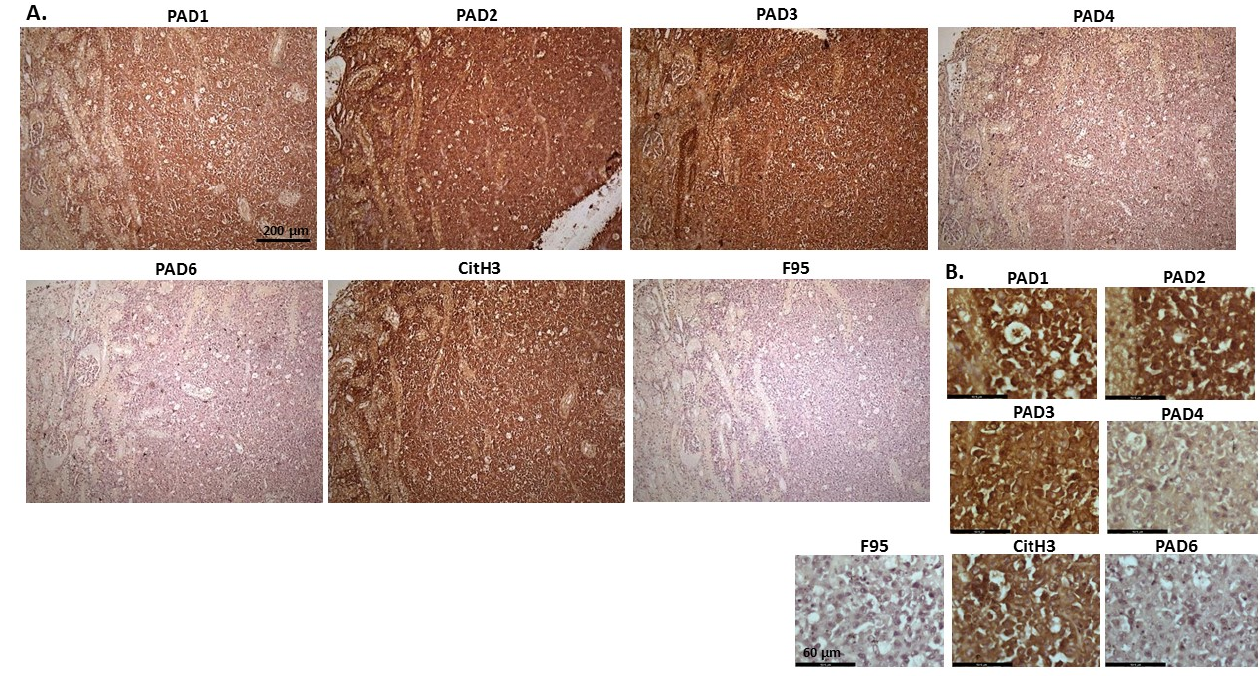
Figure 16. Cat, malignant tumour in kidneys; probably lymphoma. ( A ) Overview images for PAD1, 2, 3, 4, 6, CitH3, and F95 stainings of serial tissue sections; scale bar represents 200 μ m for all images; 10× objective. (B) Higher magnification shown for each staining from the images in ( A ); scale bar represents 60 μ m for all images; 40× objective.